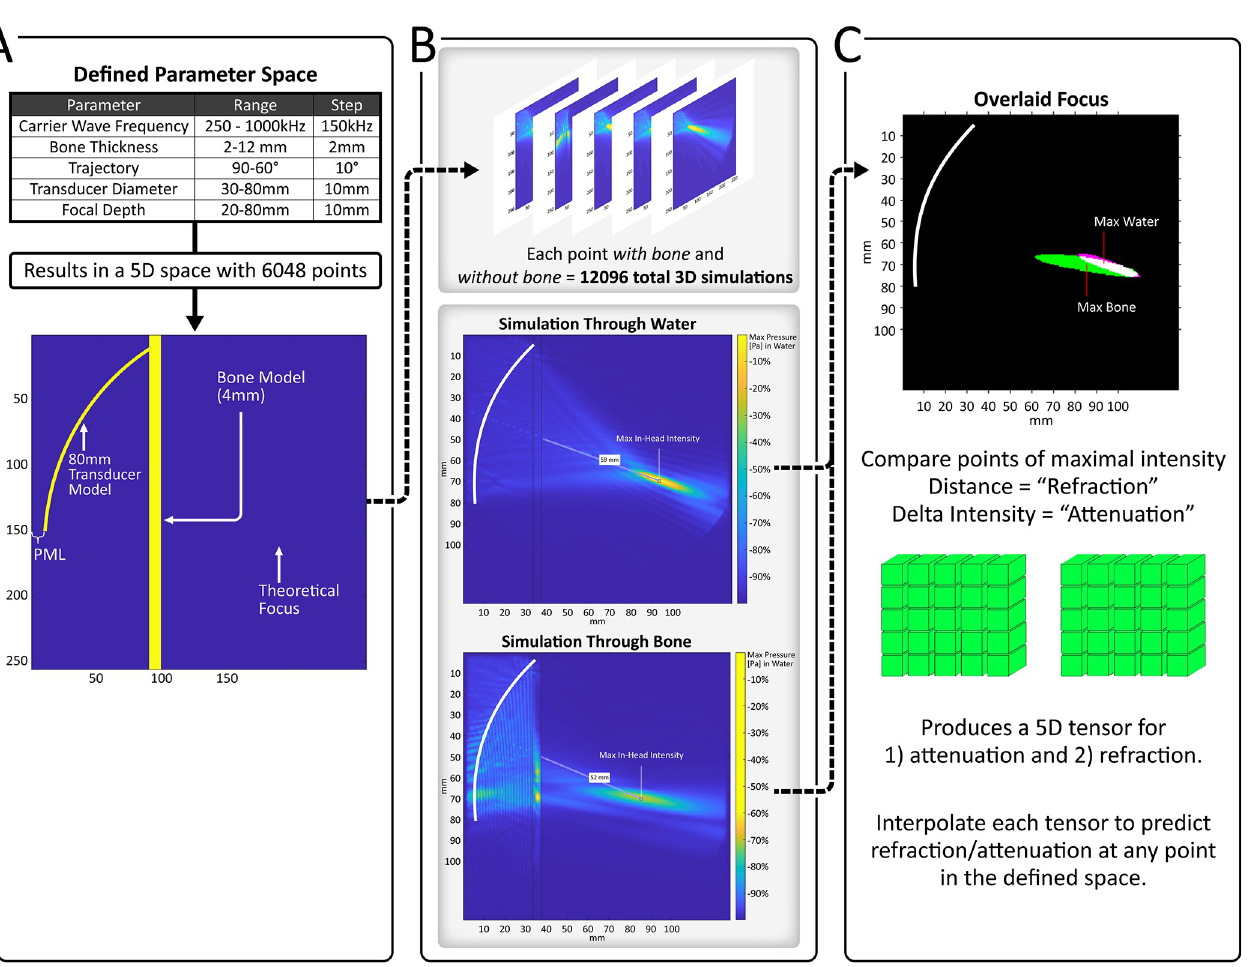
Fig 2. Workflow for the creation of the dataset provided in SMART_FUS. As described in more detail in the Methods section, a 5-dimensional parameter space was first defined and discretized. From this, 6,048 unique simulation environments were constructed (shown in A ). Simulations with bone and water as well as through only water were run for each of these environments (resulting in 12,096 total simulations). The value and position of the peak intensity were located for bone and water simulations at each of the 6,048 points in the space defined. The distance between these points defined the observed “refraction” and the difference in intensity between these points defined the observed “attenuation” at each point in the space. Thus, one 5D “refraction” tensor (an array of 3D matrices) and one 5D “attenuation” tensor were created. These tensors are linearly interpolated according to the values input into SMART_FUS and are used to predict attenuation/refraction at any point within the described parameter